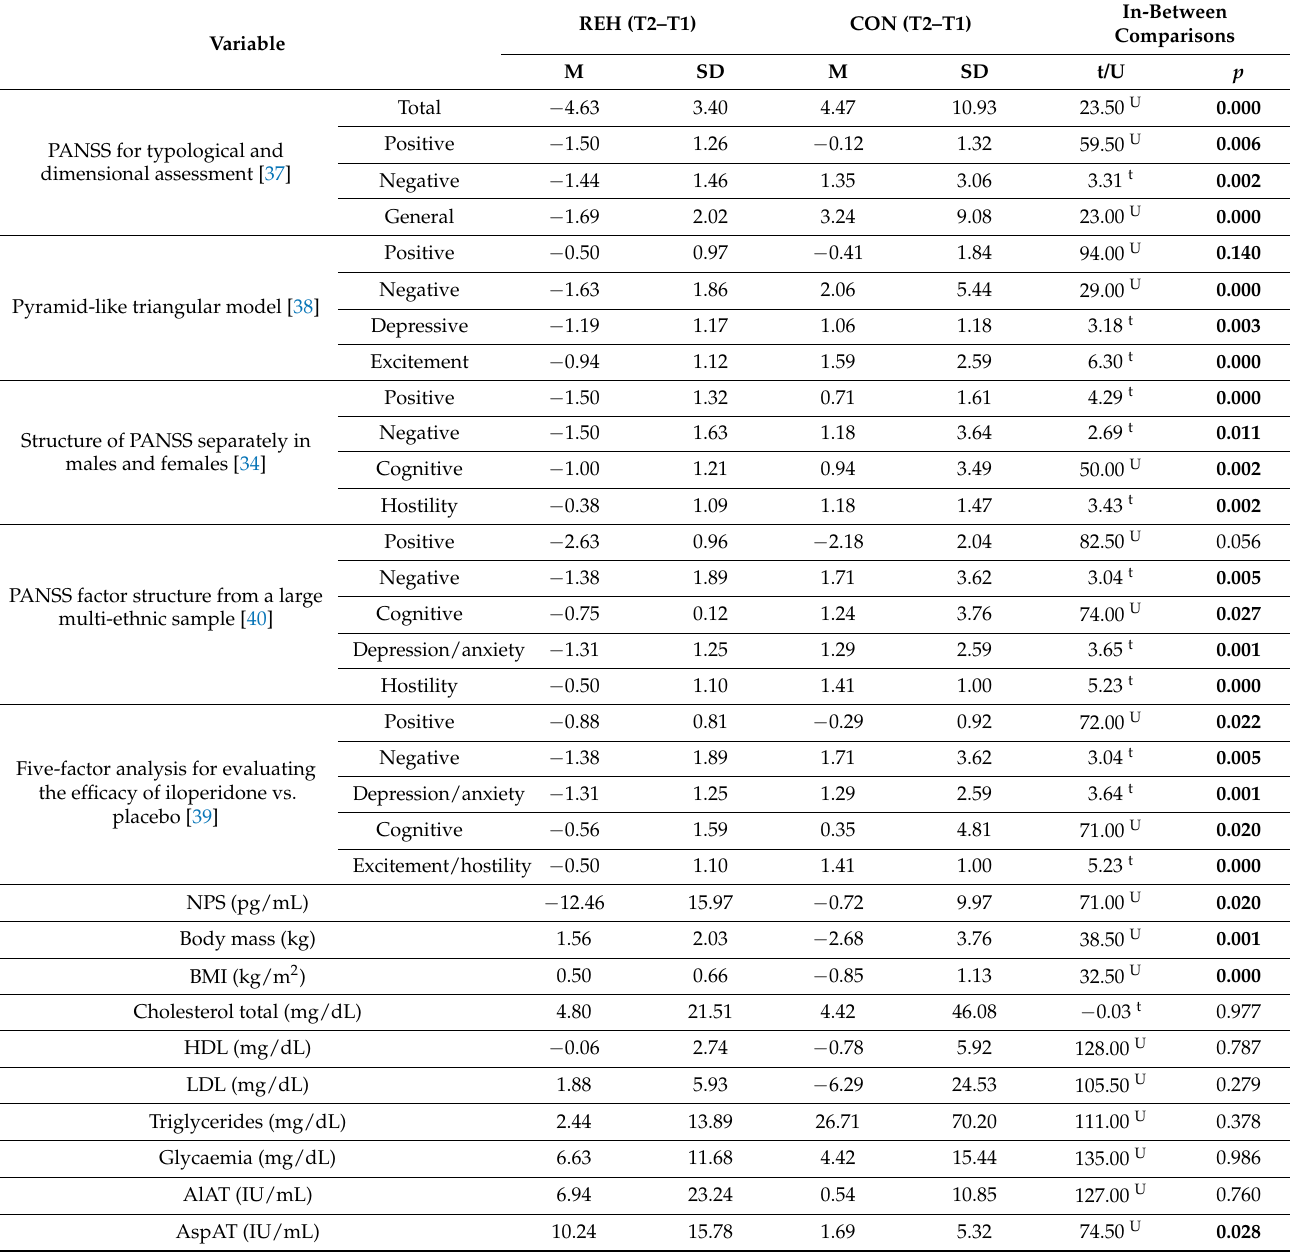
Table 4. Differences in the magnitude of changes from pre- (T1) to post-therapy (T2) results between REH and CON